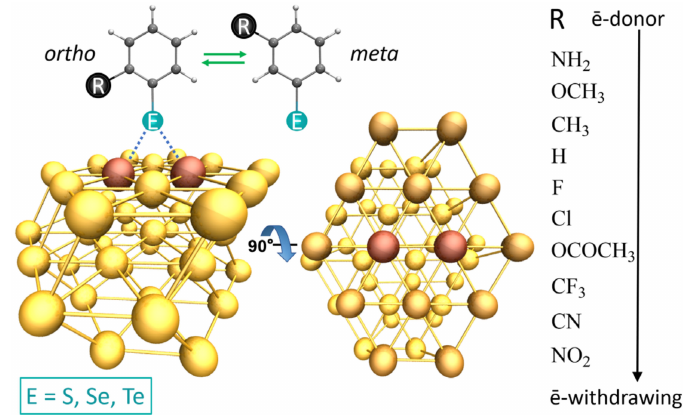
Figure 1. Schematic representation of the gold molecular system and the ligands used to model the gold-chalcogen interaction. The chalcogen atoms are represented by the sphere in cyan and it is pictured in the ortho substituted system ( left ) and meta substituted ( right ).